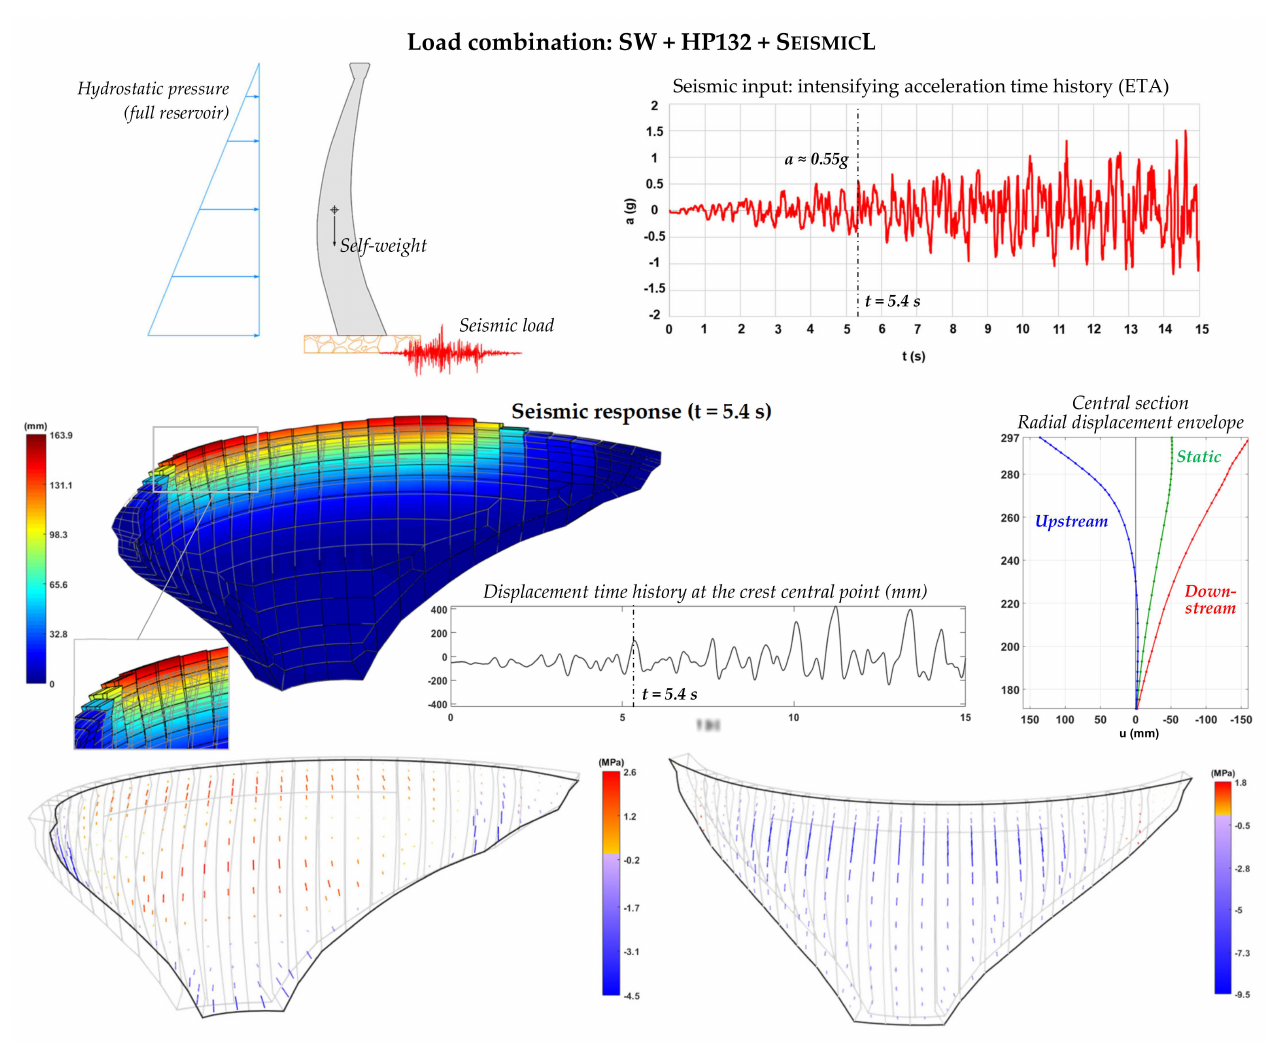
Figure 9. Non-linear seismic analysis of Cabril Dam. Deformed shape and principal stresses for t = 5.4 s, radial displacement envelope at the central section (until t = 5.4 s), and displacement time history at the crest central